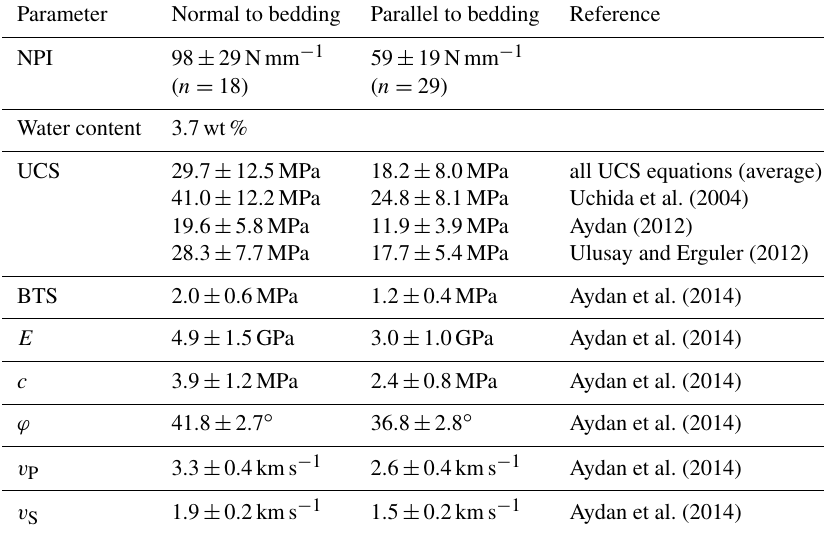
Table 4. Estimated geomechanical and geophysical parameters for the Opalinus Clay in the EZ-B niche normal and parallel to bedding based on the needle penetration